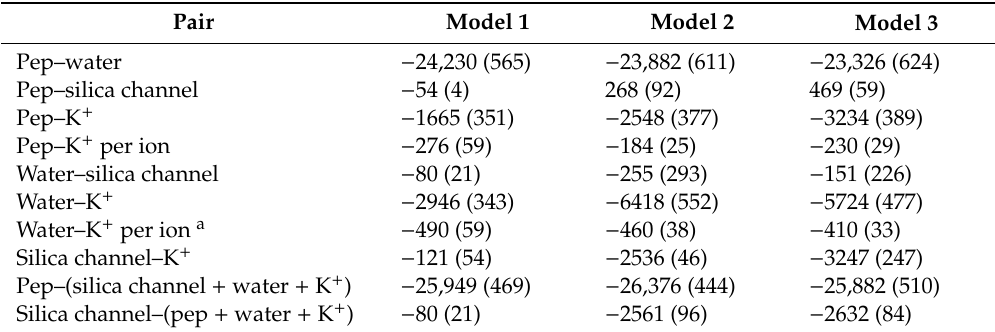
Figure 3. Radial distribution functions g(r) calculated for the simulations with the neutral channel (Model 1, black lines), with the charged channel (Model 2, red lines) and with a lower number of water molecules (Model 3, green lines). Panel ( a ): pepsin atoms—cations radial distribution functions; panel ( b ): pepsin–water oxygen atoms radial distribution functions; panel ( c ): radial distribution functions between the charged protein residues and surface oxygens from Model 2; panel ( d ) and Model 3. The g(r)’s for positively and negatively charged residues are in blue and red, respectively. Table 1. Pair interaction energies (in kJ mol − 1 ) for Model 1, Model 2, and Model 3, respectively. Standard deviations in